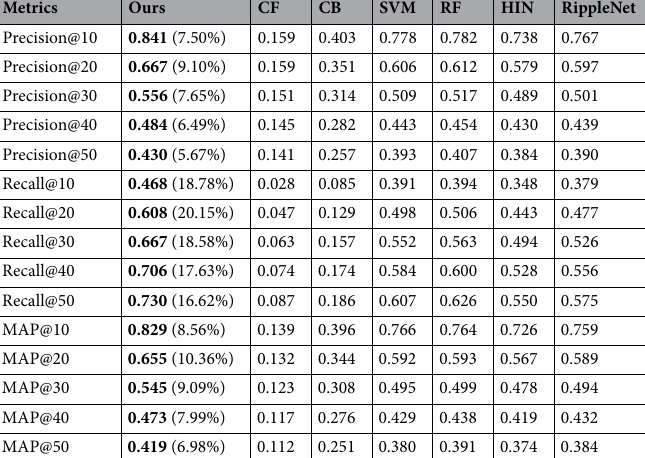
Table 4. Recommendation performance of different methods. Bold numbers represent the best performance of corresponding metrics and numbers in brackets indicate the improvement of the proposed method compared to the best baseline